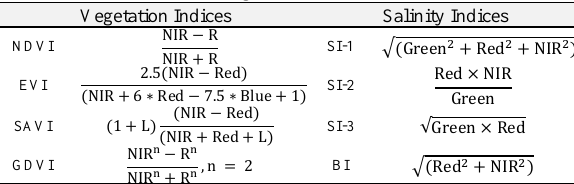
Table 1. Direct and indirect salinity indicators for detecting and assessing salt affected areas Vegetation